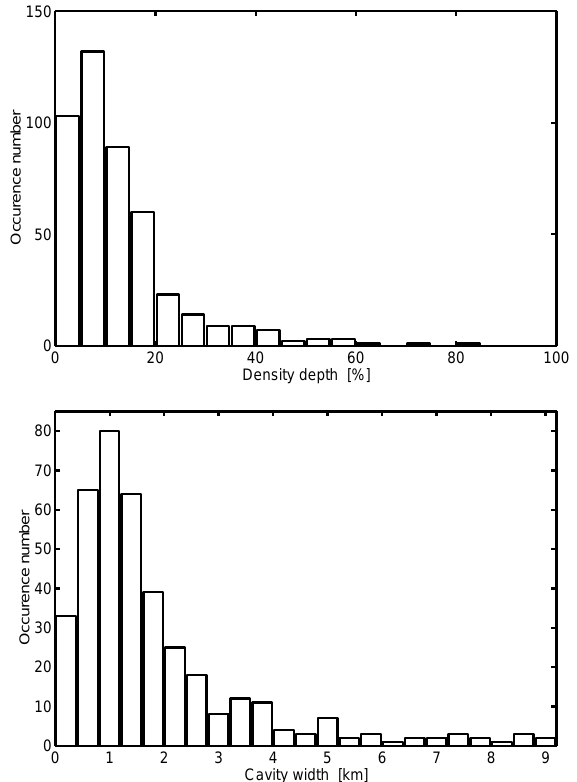
Fig. 9. The distribution of the depths and widths of the identified Cluster LHCs. The widths are determined using the plasma velocity relative to the spacecraft, calculated from the measured electric and magnetic fields.